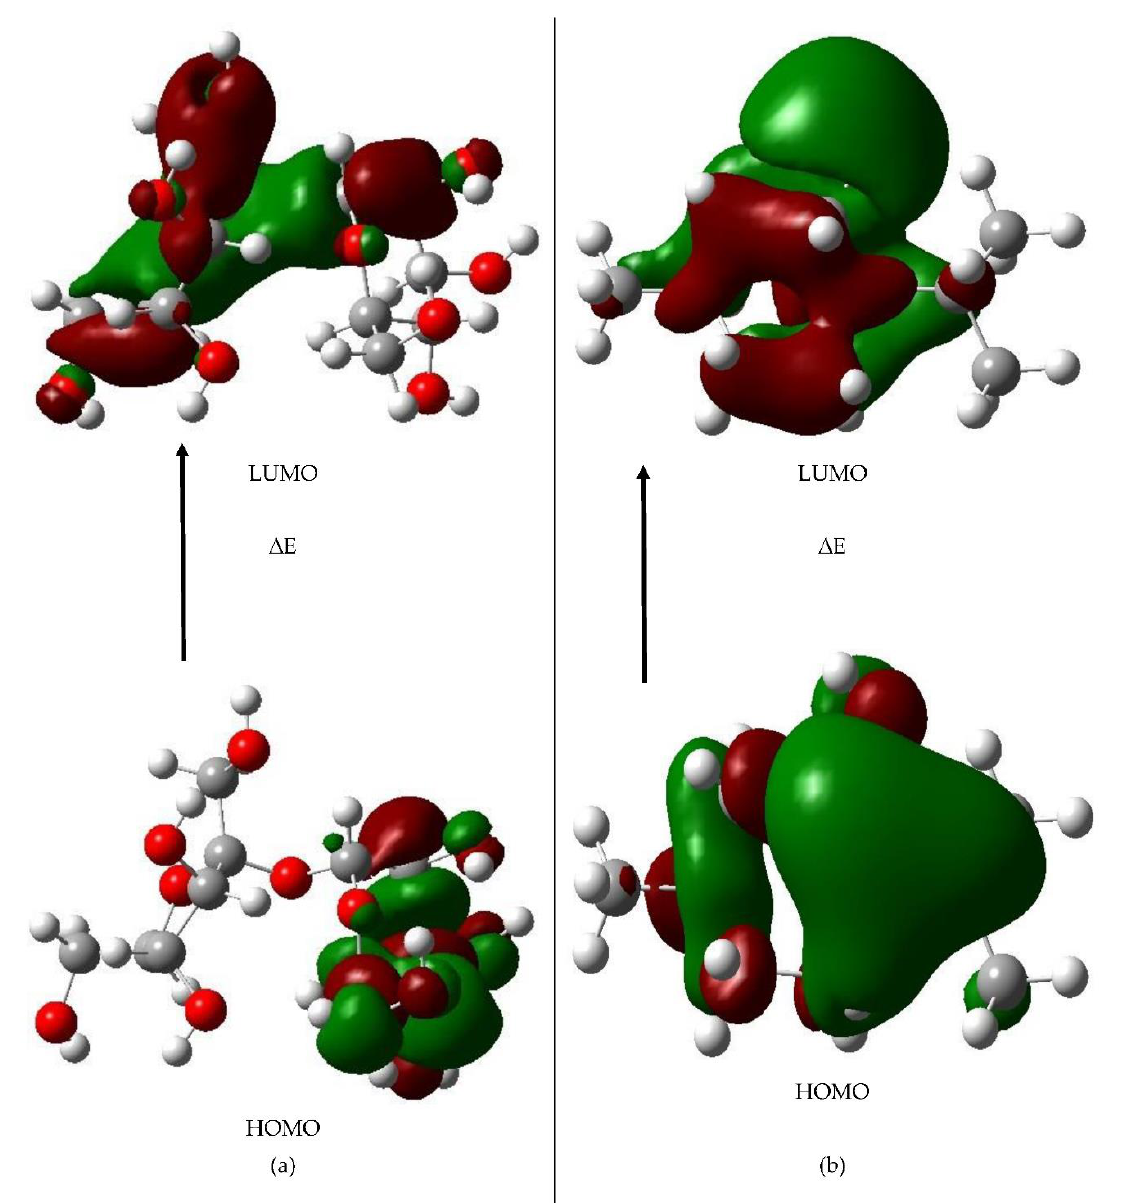
Figure 3. Plots of frontier orbitals and energy gap for ( a ) Honey and ( b ) Mint.